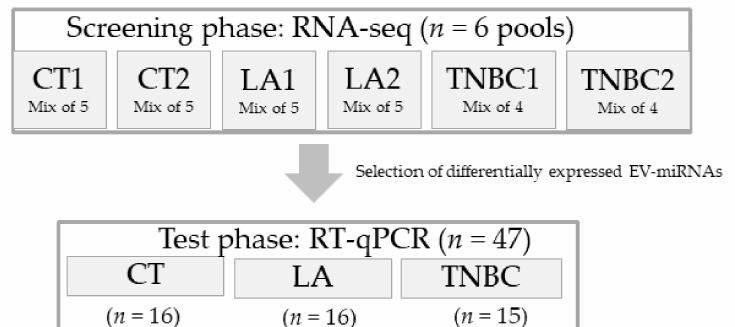
Figure 1. Schematic diagram of the workflow of this study. This study was designed in two phases. During the screening phase we performed RNA sequencing (RNA-seq) analysis in six pools of sample composed of two sample per group (Control (CT), Luminal A (LA), and Triple-negative (TNBC). During the test phase, a selection of EV-miRNAs found to be di ff erentially expressed in the RNA-seq analysis was chosen to be tested in 47 individual patient samples’ by quantitative real-time PCR